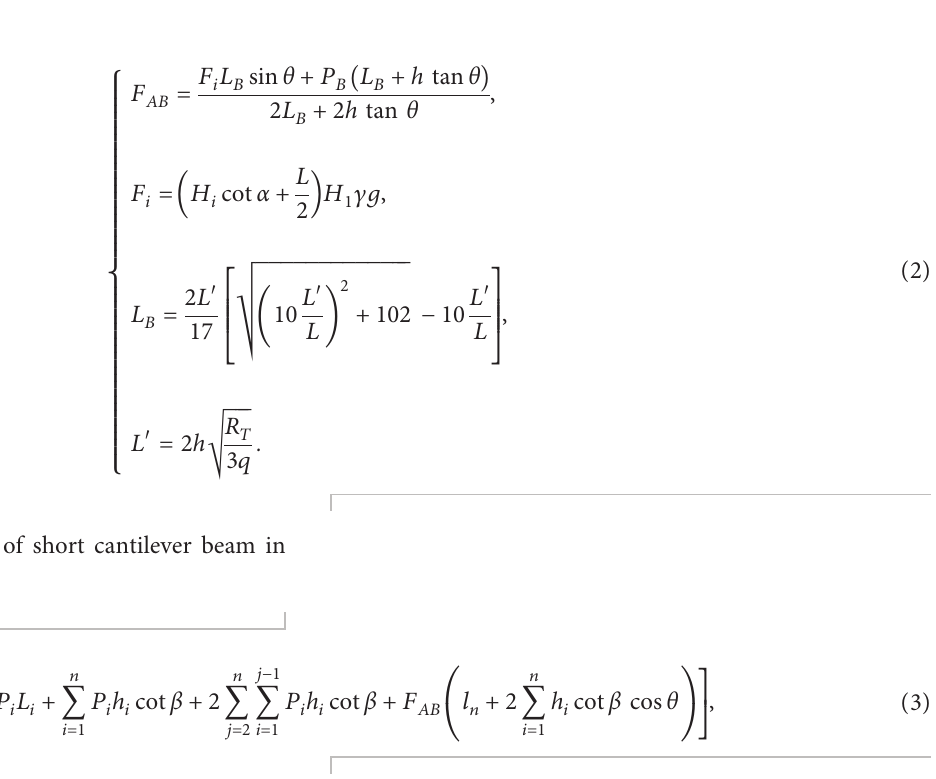
Figure 2: A-B-C coal body “chain-type” energy transfer process. (a) Zoning diagram of rock energy storage state. (b) Diagram of energy transfer process of